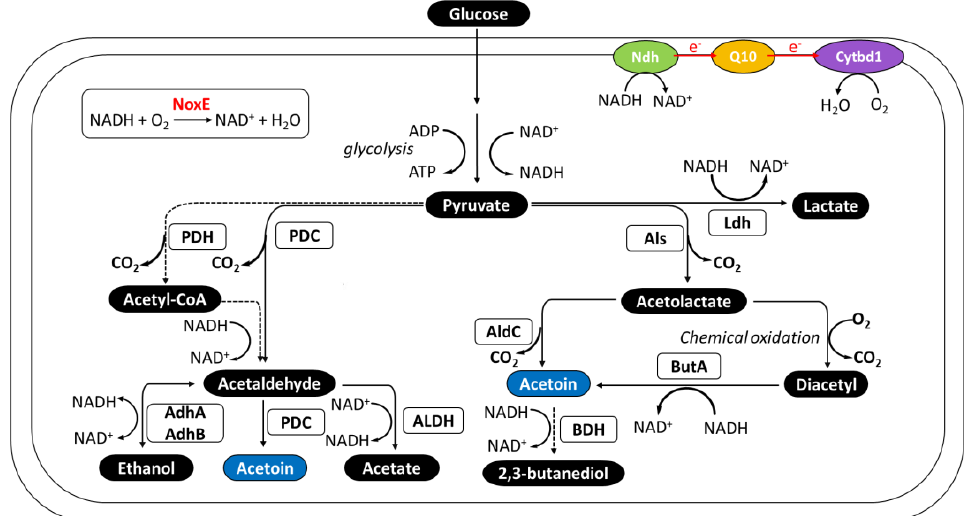
Figure 1. The native glycolysis and ethanol production pathways in Z. mobilis and potential acetoin biosynthesis pathways. The native pathways of Z. mobilis are shown with solid line, and heterologous pathways are shown with dashed lines. NoxE (Red color font) is a heterologous NADH oxidase. AdhA/B, alcohol dehydrogenase; AldC, acetolactate decarboxylase; ALDH, Aldehyde dehydrogenase; Als, acetolactate synthase; BDH, 2,3-butanediol dehydrogenase; ButA, Acetoin dehydrogenase; Ldh, lactate dehydrogenase; PDC, pyruvate decarboxylase; PDH, pyruvate dehydrogenase.